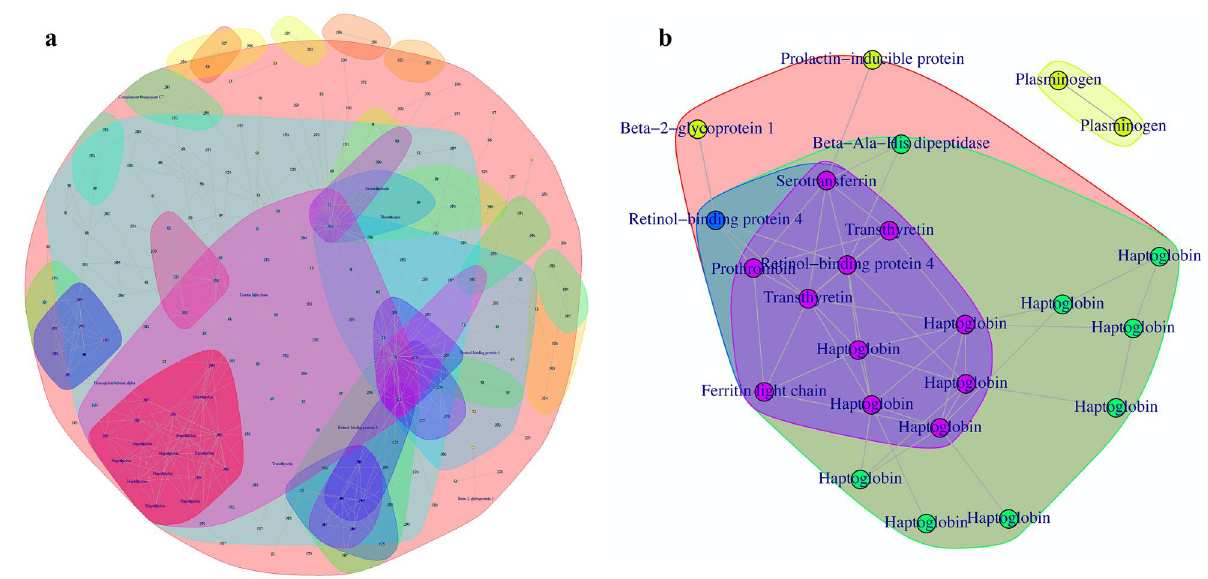
Figure 5. Protein network analysis. ( a ) A conditional independence network of all spots with lFDR < 0.99. ( b ) A conditional independence network among significant spots. Partial correlations lower than 20% were removed. Each community is represented by different colors, enclosing proteins that are closest to one another in the